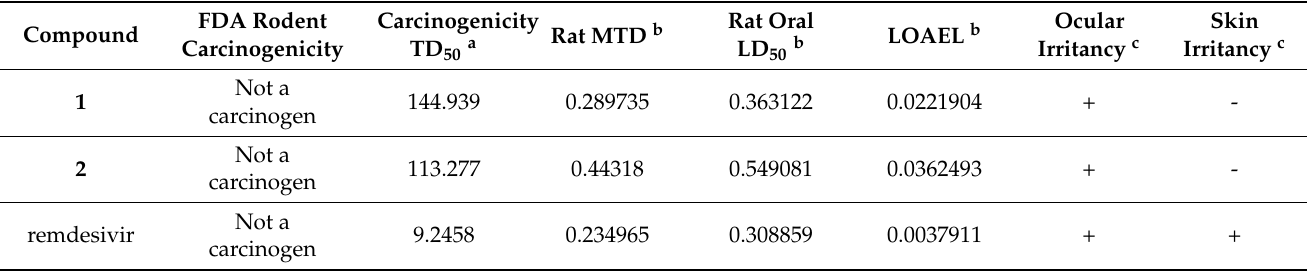
Table 4. Toxicity properties of